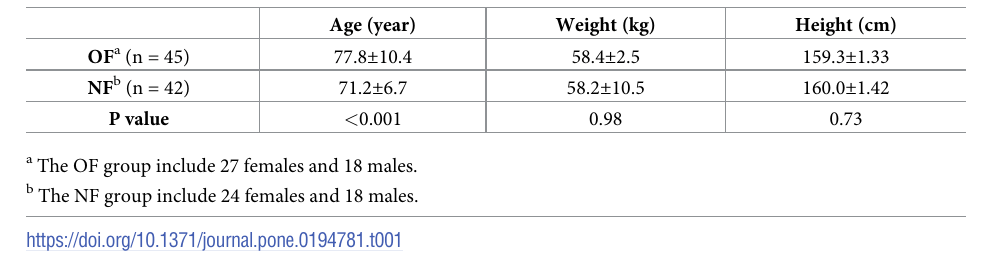
Table 1. Basic characteristics of the study Sample